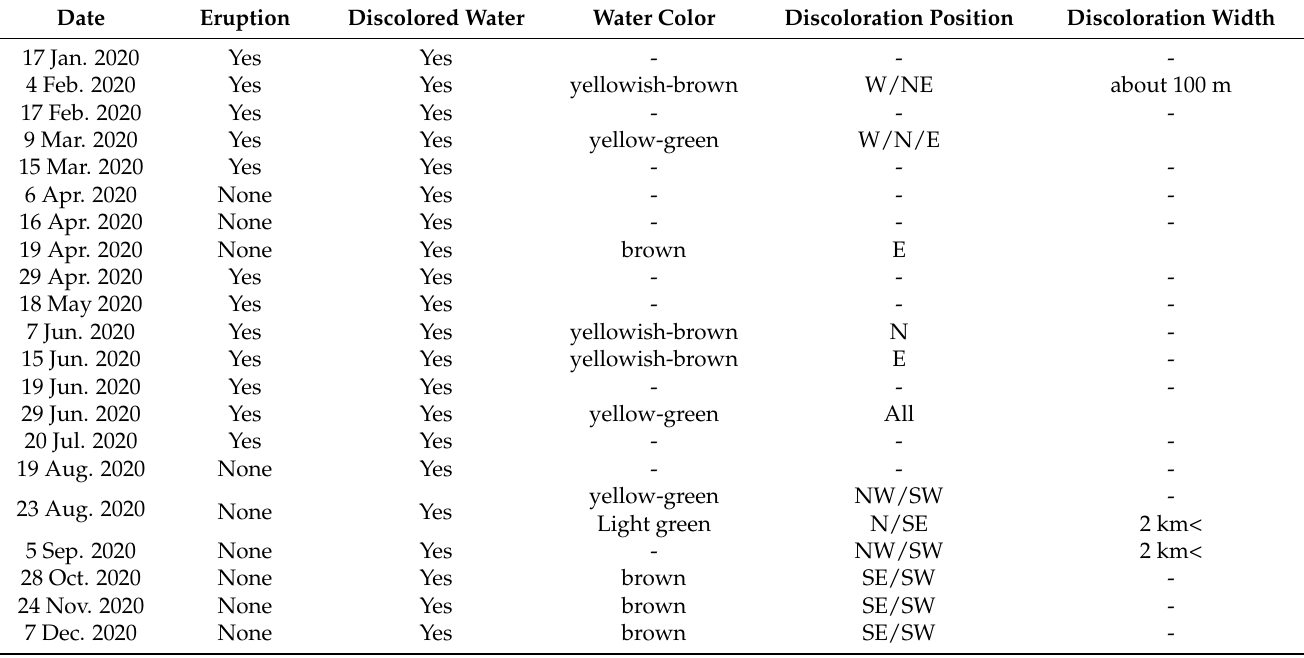
Table 3. Volcanic activity record of Nishinoshima Island obtained through visual observations by the Japan Coast Guard. (The discoloration information has been modified into a short